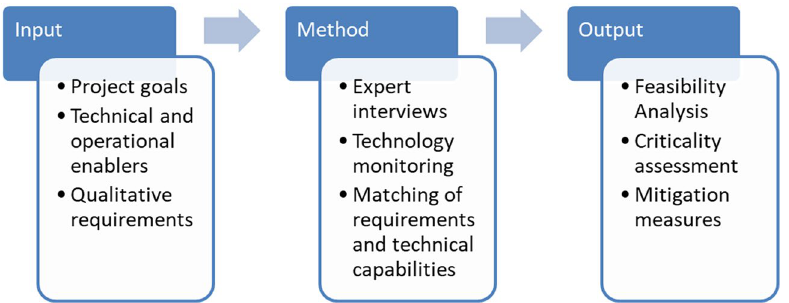
Figure 3. Methodical approach to feasibility analysis, based on 29 .